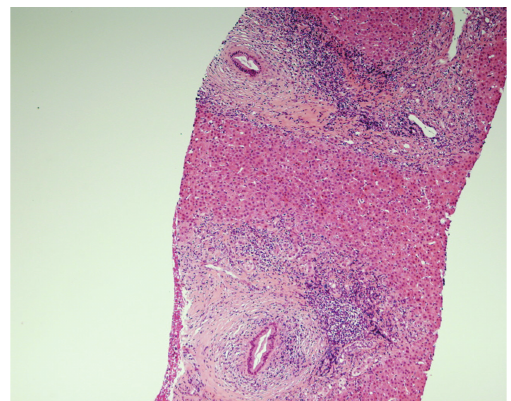
Figure 2: Marked expansion of portal tracts by fibrosis and inflam- mation (low-power view).